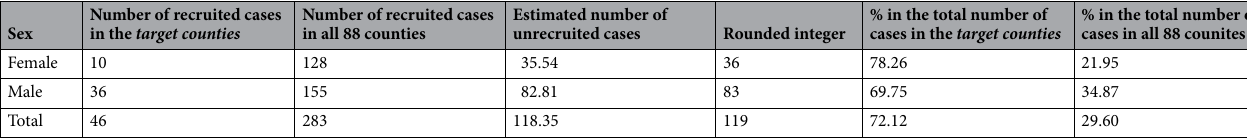
Table 2. Final estimated cases unrecruited by the Ohio ALS Registry during 2016–2018. “% in the total number of cases in the target counties” and “% in the total number of cases in all 88 counties” were calculated with the rounded integer number of unrecruited cases divided by the number of expected cases, where the number of expected cases equals to the sum of the number of recruited cases and unrecruited cases.